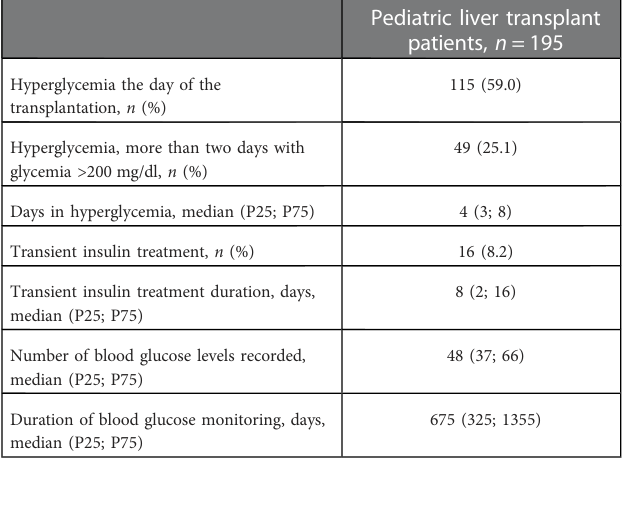
TABLE 3 Incidence of hyperglycemia in LT cohort (rDIABGRAFT).